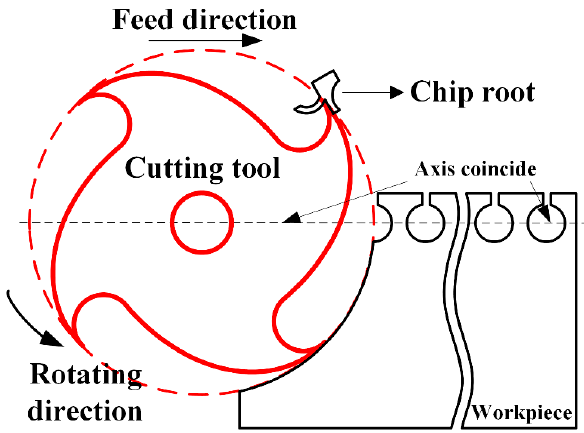
Figure 4. Schematic of Buda’s experimental method.